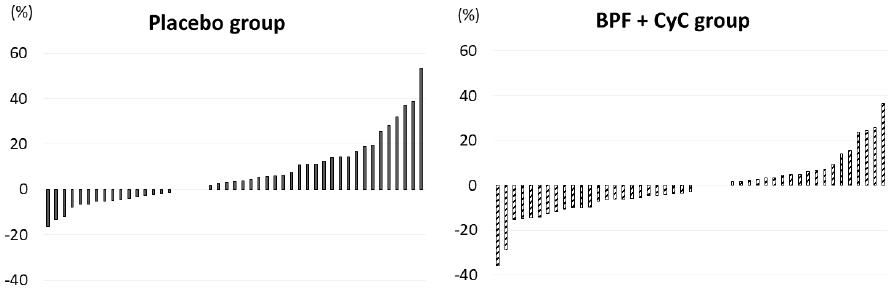
Figure 1. Individual reduction of SUA concentration according to treatment after 6 weeks. Abbrevia- tion: BPF: polyphenolic fraction of bergamot; CyC: Cynara